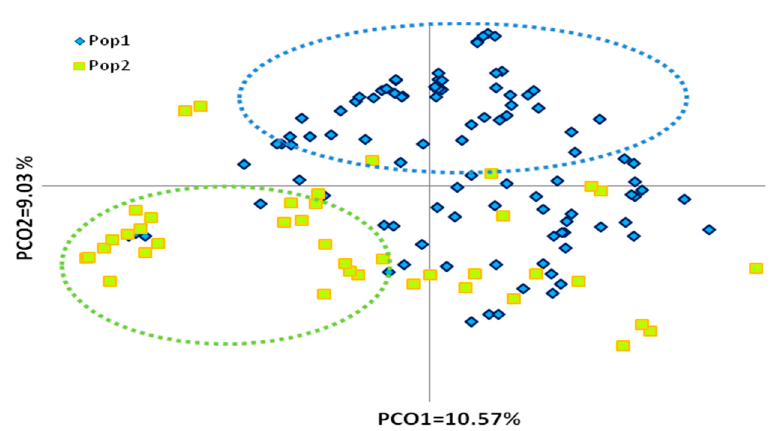
Figure 3. PCoA plot of 183 native olive genotypes, defined according to their main geographical area of distribution/origin (Adriatic vs. Ionic region). Pop 1—Genotypes distributed at Adriatic region, Pop 2—Genotypes distributed at Ionic region.